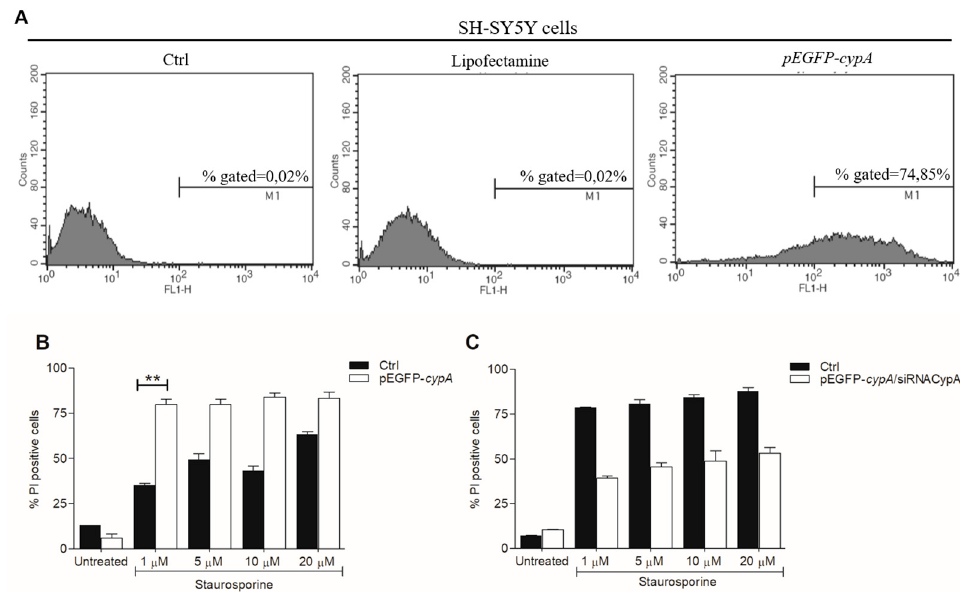
Figure 2. CypA overexpression increases STS-induced cell death in SH-SY5Y cells. ( A ) Assessment of pEGFP- cypa plasmid transfection efficiency after 24 h using flow cytometry monitoring the GFP fluorescence. ( B ) Quantification of flow cytometry results of PI stained SH-SY5Y cells, transfected or not (Ctrl) with pEGFP plasmid coding CypA (pEGFP- cypa ) and treated with STS for 3 h at the indicated concentrations (n = 8, ** p < 0.01). ( C ) Quantification of flow cytometry results of PI stained SH-SY5Y cells, co-transfected with pEGFP- cypa /siRNACypA or transfected only with pEGFP- cypA (Ctrl) and treated with STS for 3 h at the indicated concentrations.